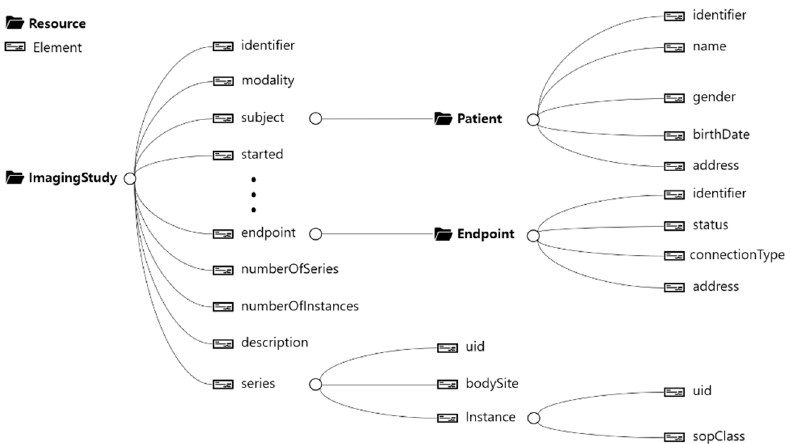
Figure 1. Medical Imaging Related Resource Diagram (ImagingStudy, Patient, Endpoint).